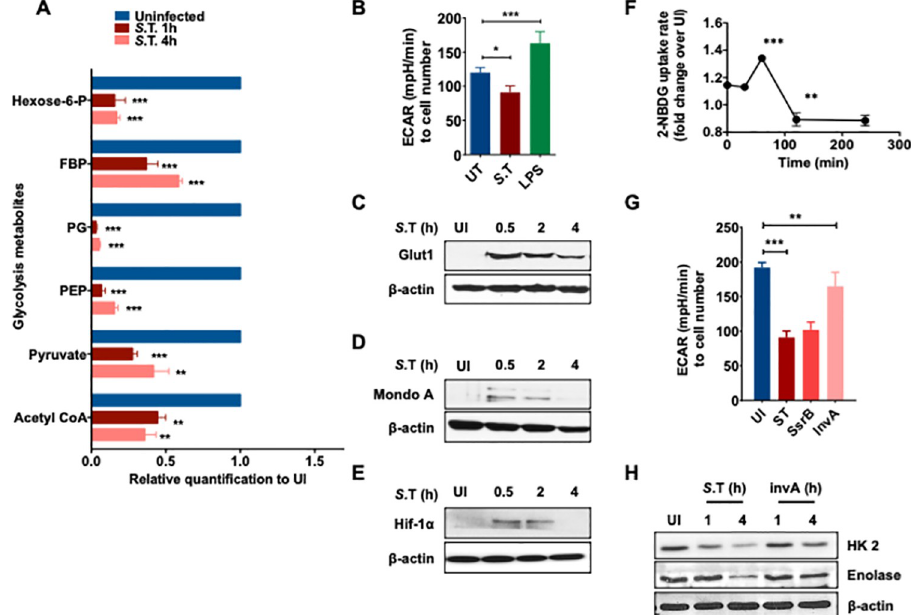
Fig 2. Virulence dependent inhibition of glycolysis in S . Typhimurium infected macrophages. (A) Abundance of glycolytic metabolites in S. Typhimurium-infected BMDMs after 1 h and 4 h p.i relative to uninfected (UI) BMDMs (n = 6). (B) Extracellular Acidification Rate (ECAR) in BMDMs upon S.T infection or LPS treatment. Data is normalized to cell number (n = 3). (C) Western blot analysis of Glut1 (D) MondoA (E) HIF-1alpha expression at indicated time points upon S. Typhimurium-infected BMDMs compared to uninfected controls. β -actin was used as a loading control. The image shown is representative of 4 independent experiments. (F) Kinetics of glucose-intake (shown as 2-NBDG MFI) in S. Typhimurium-infected BMDMs relative to uninfected (UI) BMDMs analyzed by flow cytometry (n = 3). (G) Extracellular Acidification Rate (ECAR) in BMDMs infected upon WT, ssrB, and invA mutant S . Typhimurium infection. Data is normalized to cell number (n = 6). (H) Immunoblot analysis of the protein levels of HexoKinase-2 (HK2, Enolase, and β -actin upon WT and InvA mutant S . Typhimurium infection.